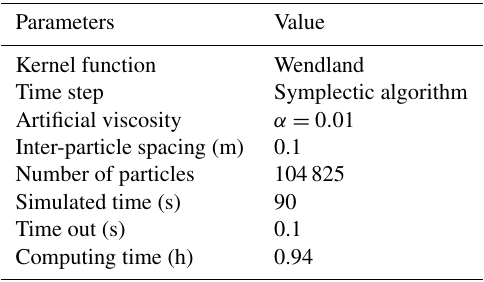
Table 12. Parameters and main characteristics of the SPH simula-